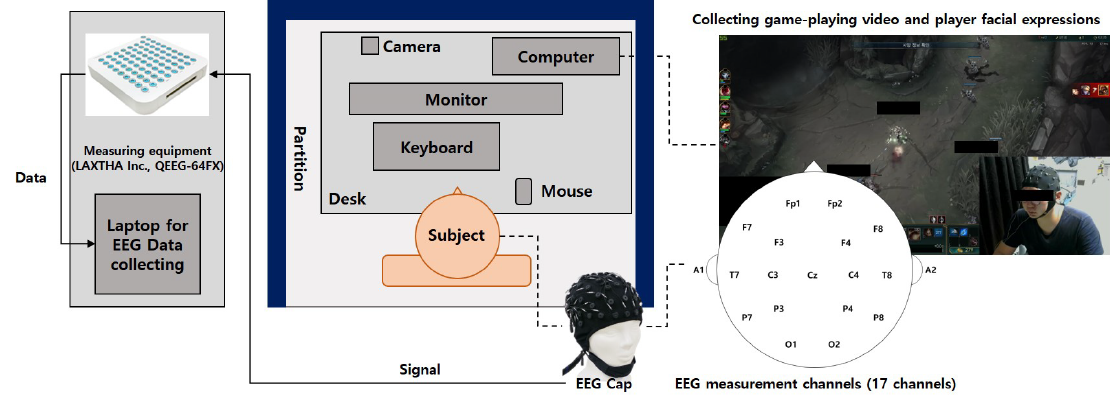
Figure 1. Experimental setting.